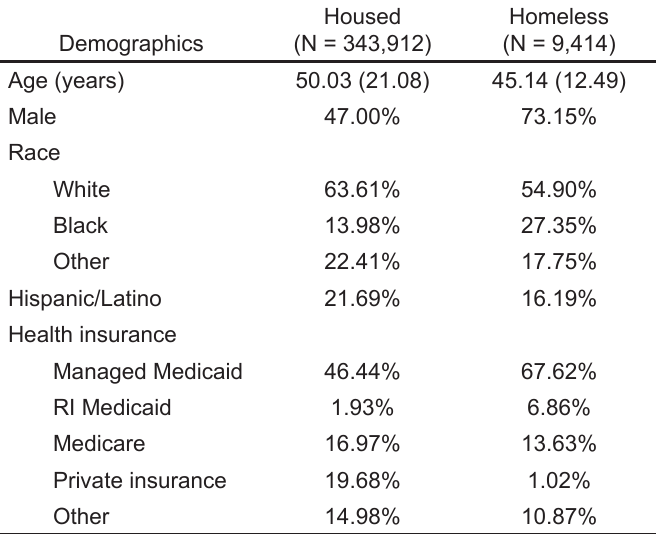
Table 1. Demographic information for housed vs homeless participants at The Miriam Hospital and Rhode Island Hospital.